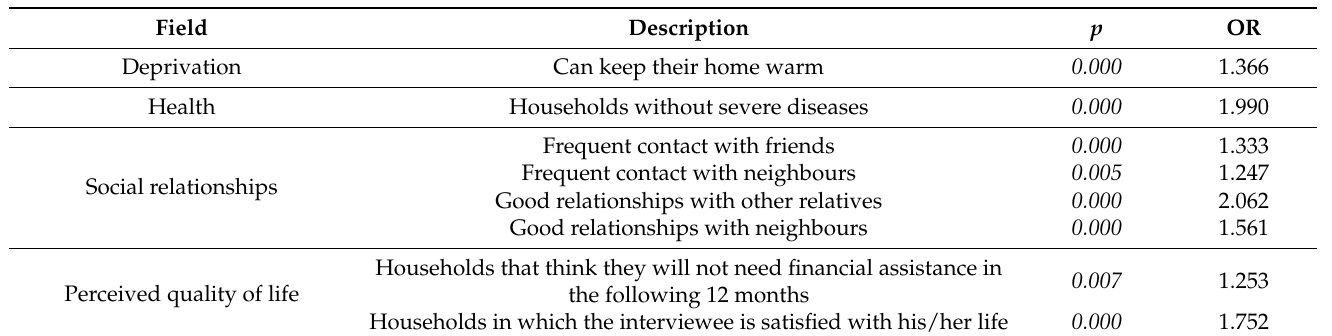
Table 3. Variables included in the protection model, significance level ( p ) and corresponding Odds Ratio